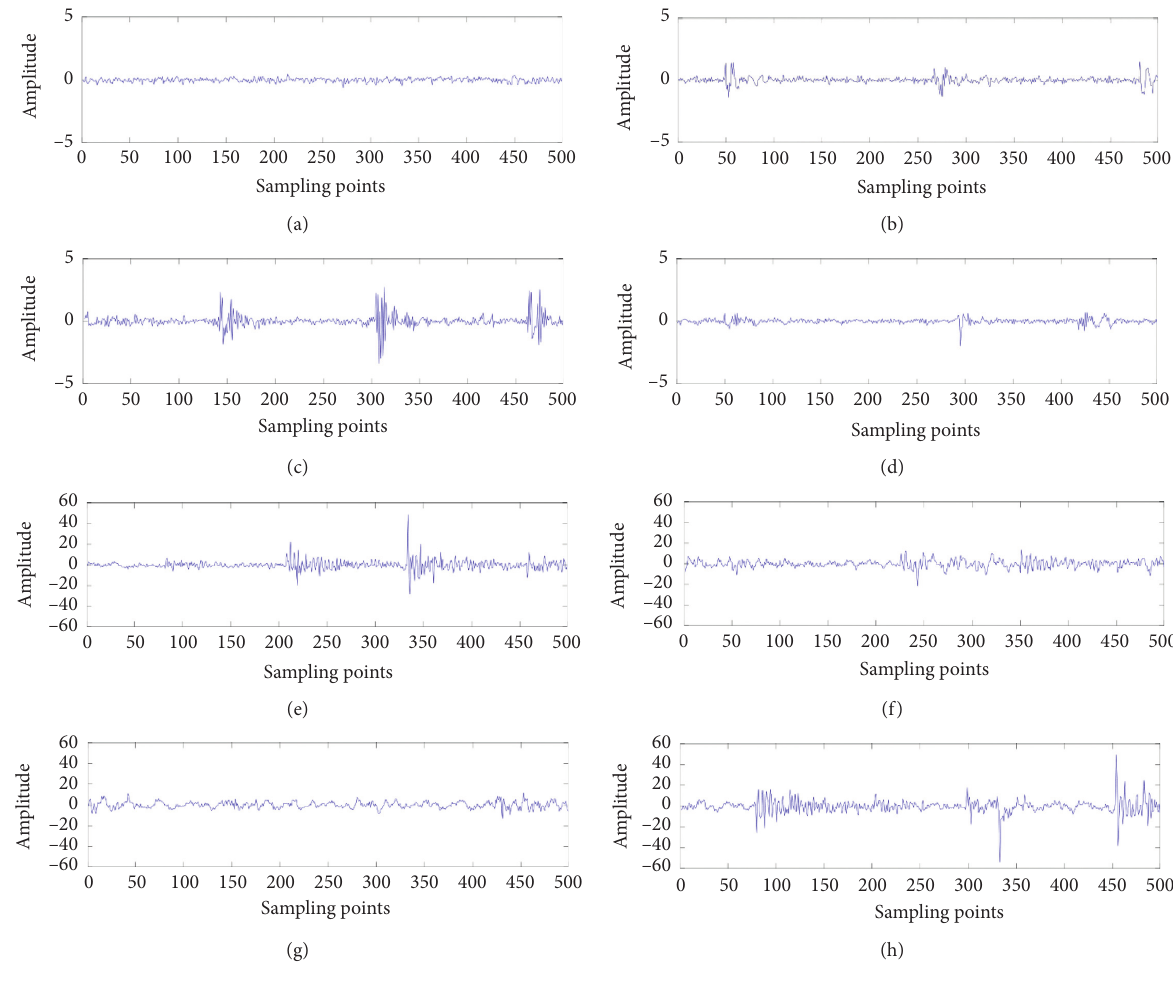
Figure 6: Bearing vibration signals. (a) NO. (b) IF03. (c) OF03. (d) BF03. (e) IB. (f) IO. (g) OB. (h) IOB.